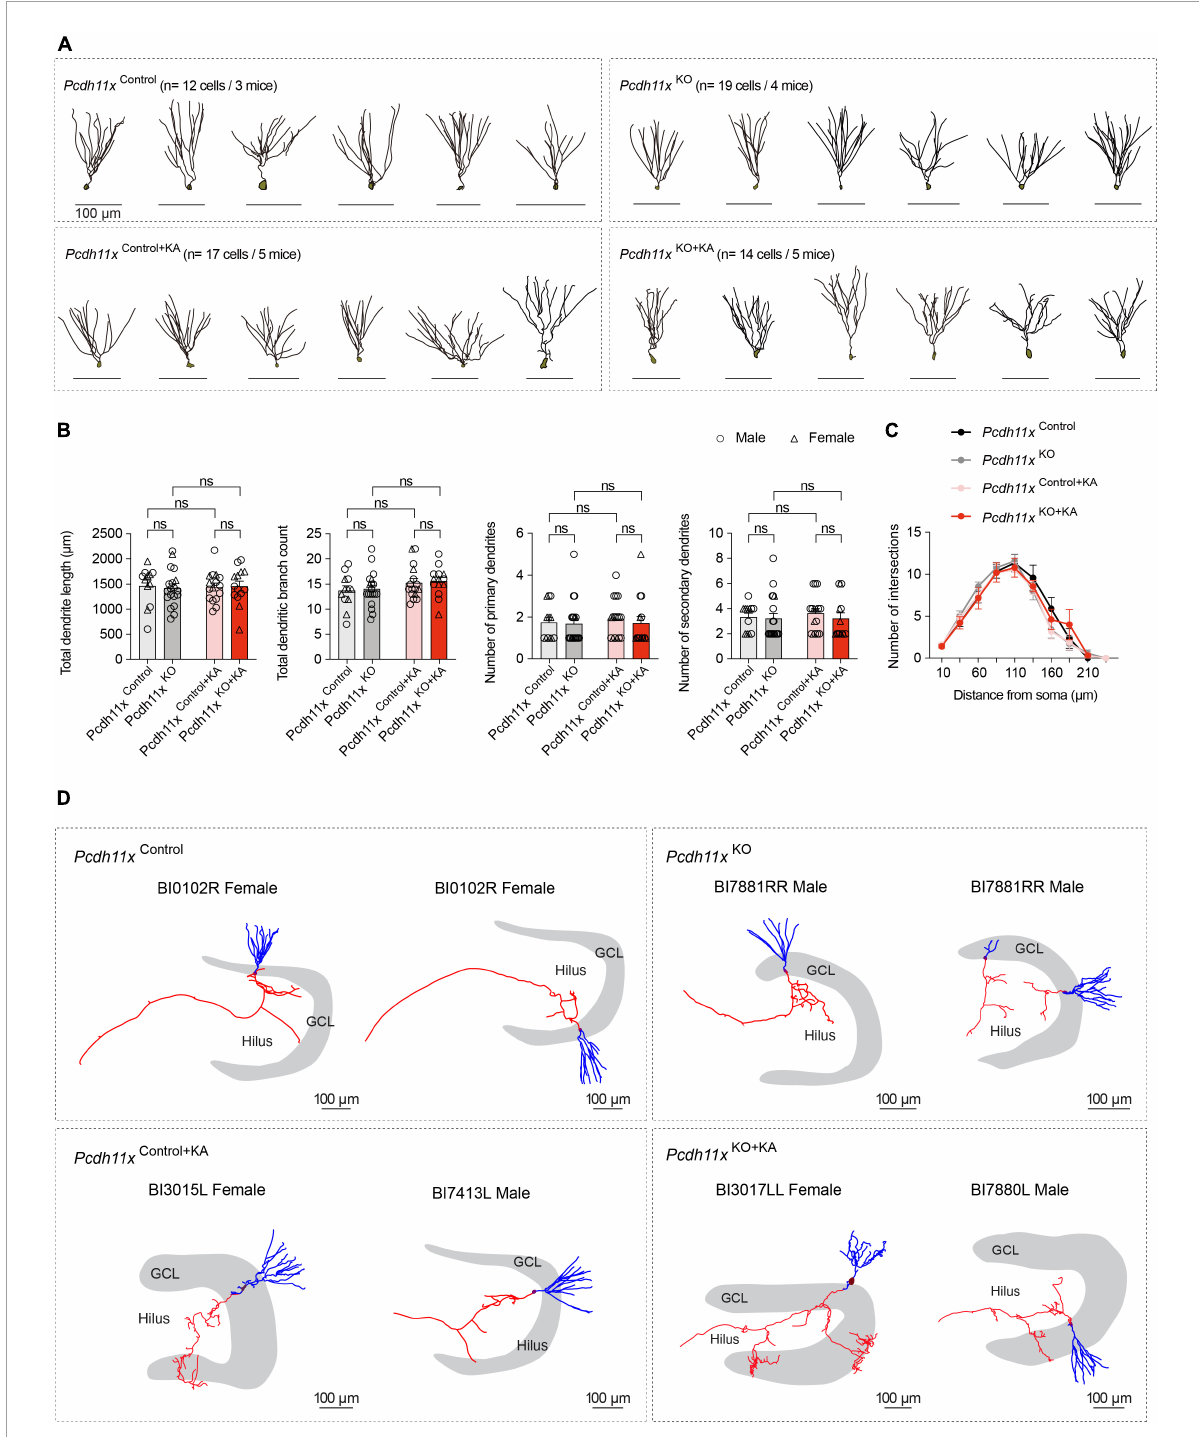
FIGURE6 Morphological characterization of Pcdh11x Control + KA and Pcdh11x KO + KA GCs. (A) Morphological reconstruction of dendrites from Pcdh11x Control , Pcdh11x KO , Pcdh11x Control + KA , and Pcdh11x KO + KA GCs. (B) Quantification of dendritic parameters, such as total dendrite length, total dendritic branch count, number of primary dendrites, and number of secondary dendrites (two-way ANOVA test; data points represent single cells). (C) Sholl analysis of dendritic complexity. None of the comparisons had significance p < 0.05 (two-way ANOVA test). (D) Morphological reconstruction of axons from Pcdh11x Control , Pcdh11x KO , Pcdh11x Control + KA , and Pcdh11x KO + KA GCs. Axons and dendrites are shown in red and blue respectively. For further examples, see Supplementary Figure 3